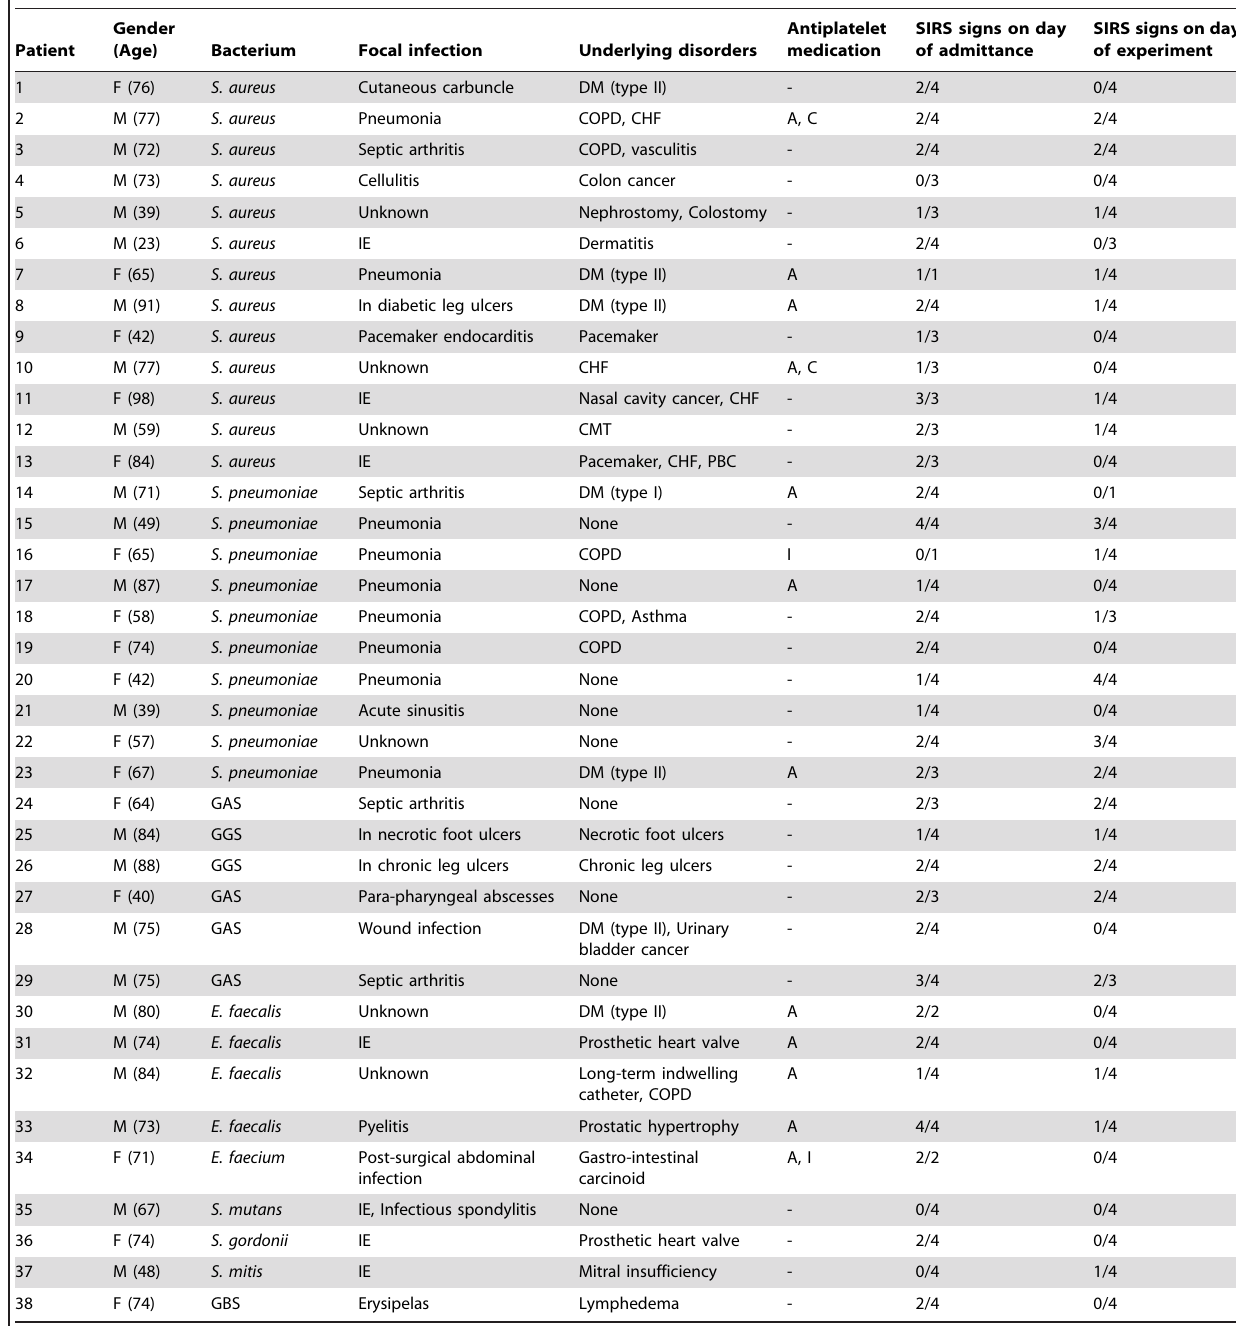
Table 1. Patient